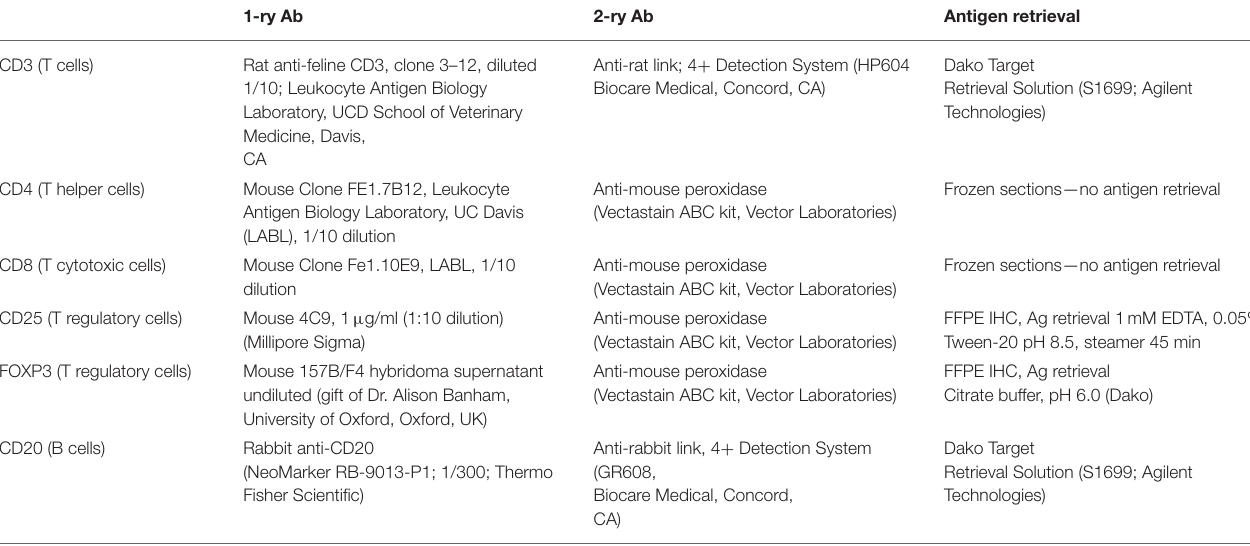
TABLE 1 | IHC antibodies and reagents.